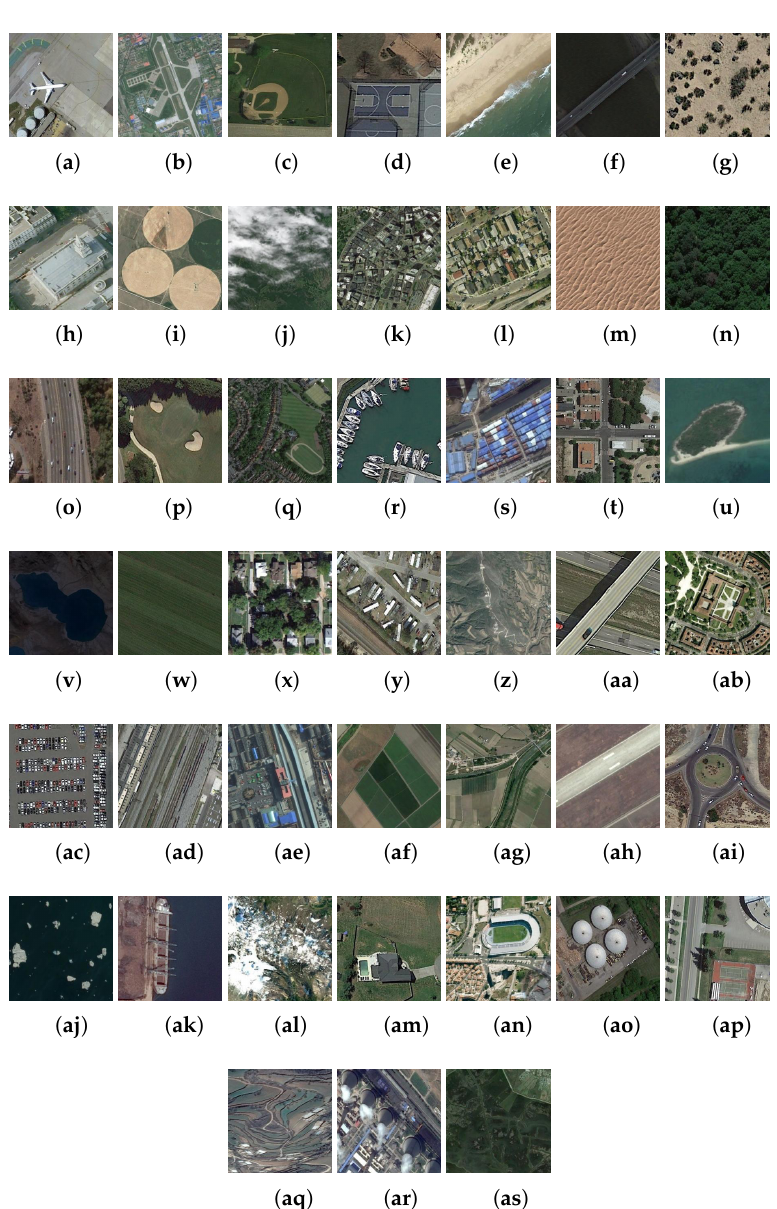
Figure 8. Image classes in the NWPU-RESISC45 dataset: ( a ) airplane; ( b ) airport; ( c ) baseball diamond; ( d ) baseball court ( e ) beach; ( f ) bridge; ( g ) chaparral; ( h ) church; ( i ) circular farmland; ( j ) cloud; ( k ) commercial area; ( l ) dense residential; ( m ) desert; ( n ) forest; ( o ) freeway; ( p ) golf course; ( q ) ground track field; ( r ) harbour; ( s ) industrial area; ( t ) intersection; ( u ) island; ( v ) lake; ( w ) meadow; ( x ) medium residential; ( y ) mobile home park; ( z ) mountain; ( aa ) overpass; ( ab ) palace; ( ac ) parking lot; ( ad ) railway; ( ae ) railway station; ( af ) rectangular farmland; ( ag ) river; ( ah ) roundabout; ( ai ) runway; ( aj ) sea ice; ( ak ) ship; ( al ) snowberg; ( am ) sparse residential; ( an ) stadium; ( ao ) storage tank; ( ap ) tennis court; ( aq ) terrace; ( ar ) thermal power station; ( as )